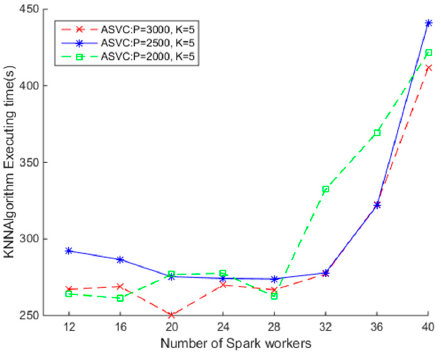
Figure 8. The impact of parameter p on the efficiency of Spark-based Nearest neighbor query algorithms (SNNQAs) using ASVC.